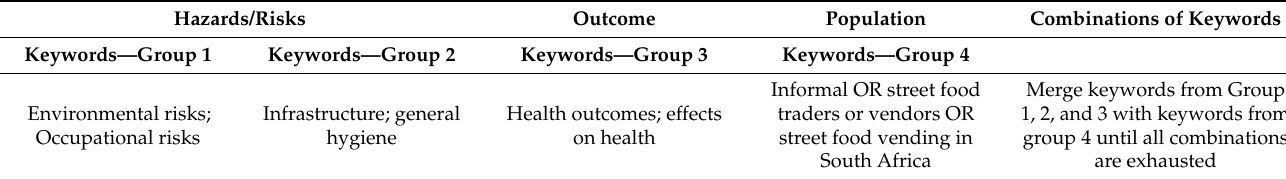
Table 1. Review keyword literature